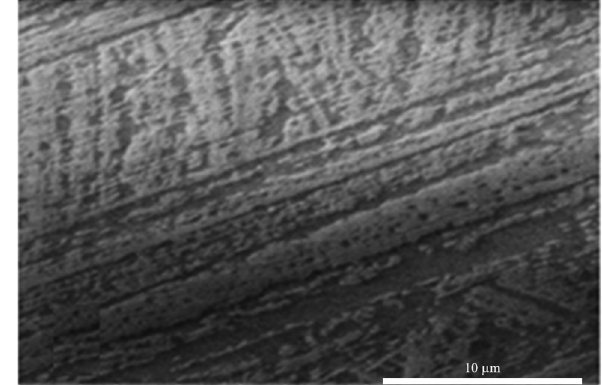
Figure 14: Uncoated alumina femoral head tested in the presence of SF ( lubricated condition ) .